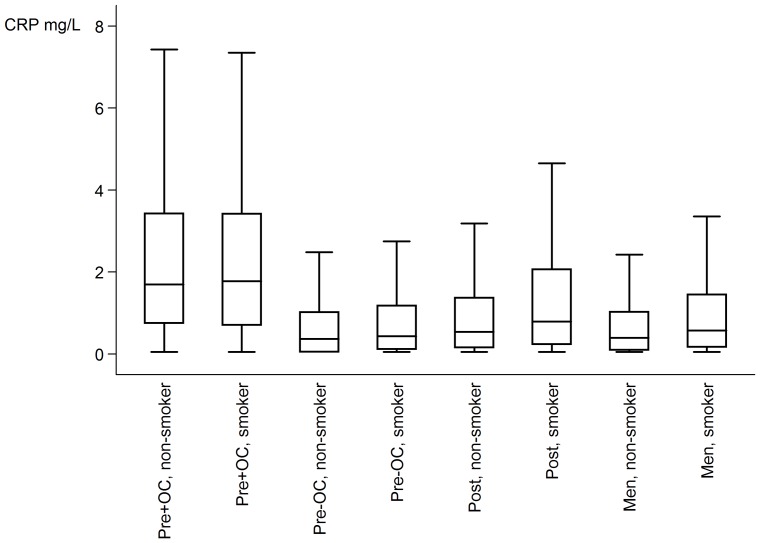
CRP levels in the cohort.Box-and-whisker plot showing the CRP levels in the four groups stratified according to smoking status. The boxes span the interquartile range with a line at the median. The whiskers represent the highest and the lowest values within 1.5 interquartile range of the nearer quartile. Due to the large size of the study, outliers are not shown. Pre+OC: premenopausal women using combined oral contraception (OC), pre-OC: premenopausal women not using OC, post: postmenopausal women.